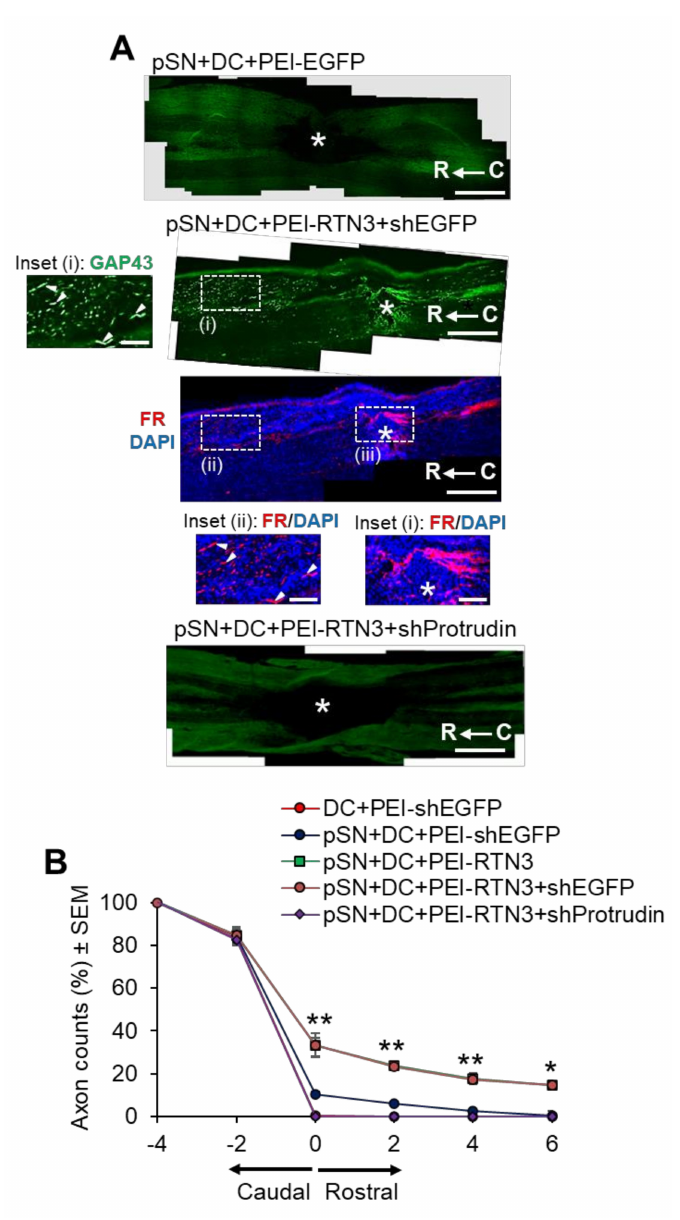
Figure 6. RTN3 overexpression promotes Protrudin-dependent DC axon regeneration. ( A ) Representative longitudinal sections of the spinal cord immunostained with GAP43 antibod- ies after treatment with pSN + DC + PEI-EGFP, pSN + DC + PEI-RTN3 + shEGFP and pSN + DC + PEI-RTN3 + shProtrudin (* = lesion site; C to R = caudal to rostral). FluoroRuby (FR) traced axons in the same sections as pSN + DC + PEI-RTN3 + shEGFP confirms overlap of GAP43 + axons (arrowheads), unequivocally demonstrating axon regeneration. Inset (i) shows high power images of GAP43 + axons in the boxed region (i). Inset (ii) and (iii) show high power images of FR + axons in boxed regions (ii) and (iii). Note the overlap (arrowheads) between GAP43 + axons in inset (i) and FR+ axons in inset (ii). ( B ) Quantification of the % of GAP43 + axons at different distances caudal and rostral to the lesion site. Scale bars in ( A ) = 200 µ m. n = 18 rats/group. * p = 0.05, ** p =